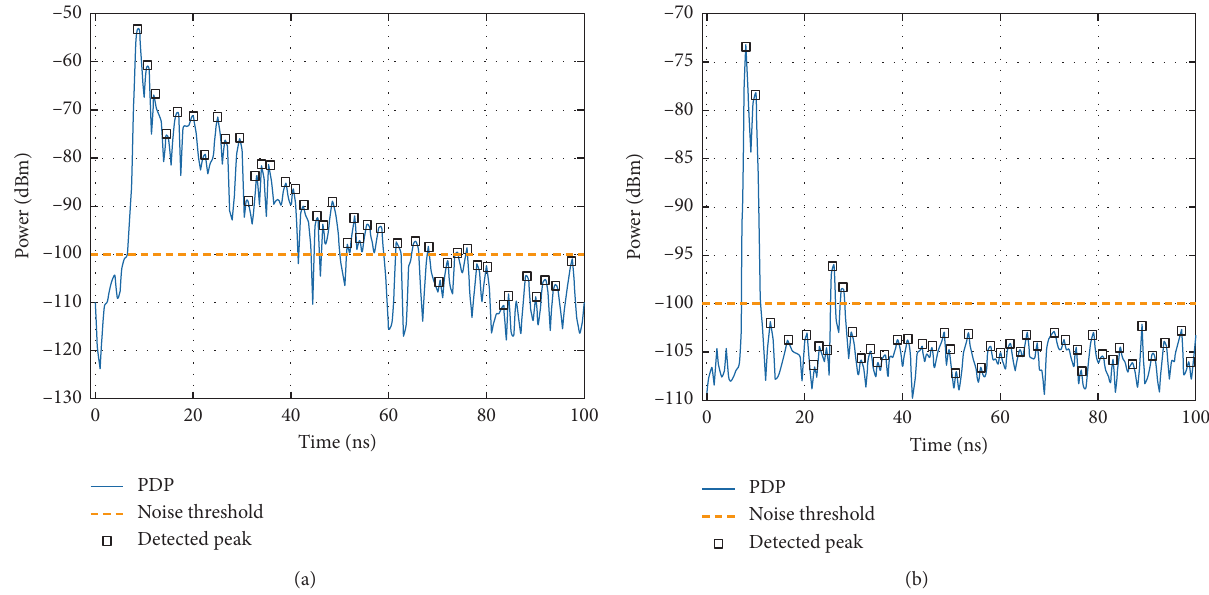
Figure 8: Examples of power delay profile (solid line), noise level (dashed line), and detected peaks (square markers) at 2.2m Tx-Rx separation distance in step 5 of stairs: (a) 3.5GHz and (b)